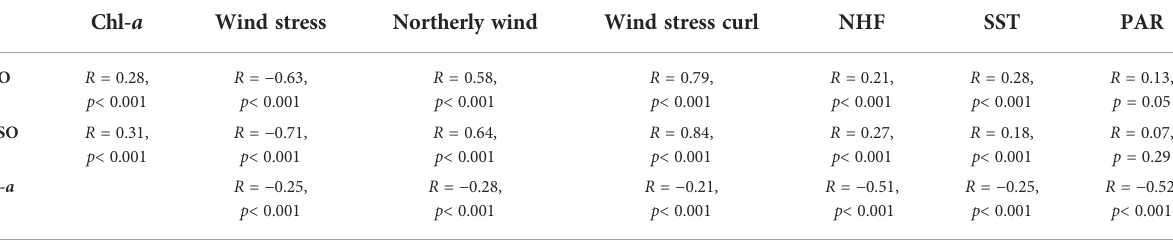
The gray font indicates that the correlation was not signi fi cant at the 95% con fi dence